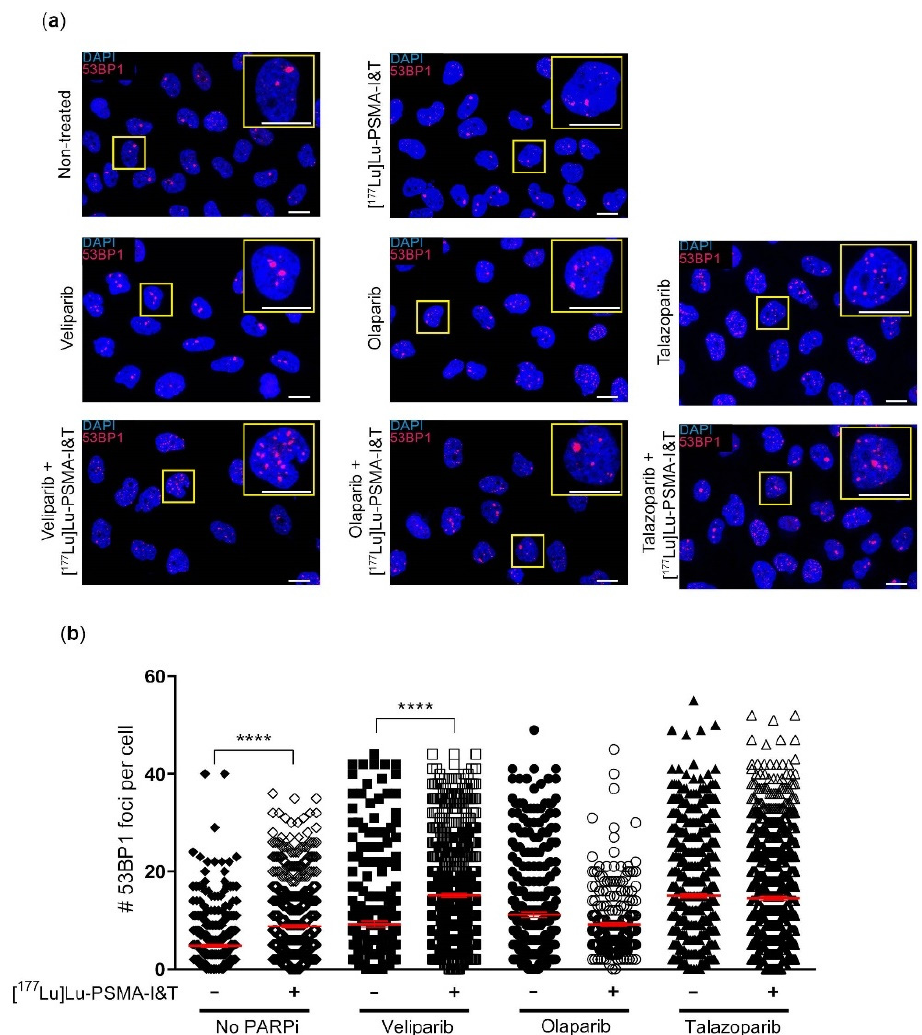
Figure 2. DSB foci in PC3-PIP cells treated with [ 177 Lu]Lu-PSMA-I&T in combination with PARPi. DSB analysis of cells treated with [ 177 Lu]Lu-PSMA-I&T with or without PARPi. ( a ) Representative images of immunofluorescent stainings. Blue: DAPI; red: 53BP1 (scale bar = 7.5 µ m). ( b ) Quantification of the number of 53BP1 foci per nucleus. Error bars indicate SEM (n = 3) (**** p ≤ 0.0001). A significant increase in the number of DSBs was seen 3 days after incubation of cells treated with [ 177 Lu]Lu-PSMA-I&T compared to the untreated control. Furthermore, cells treated with 1 µ M veliparib, 0.1 µ M olaparib or 1.5 nM talazoparib monotherapy